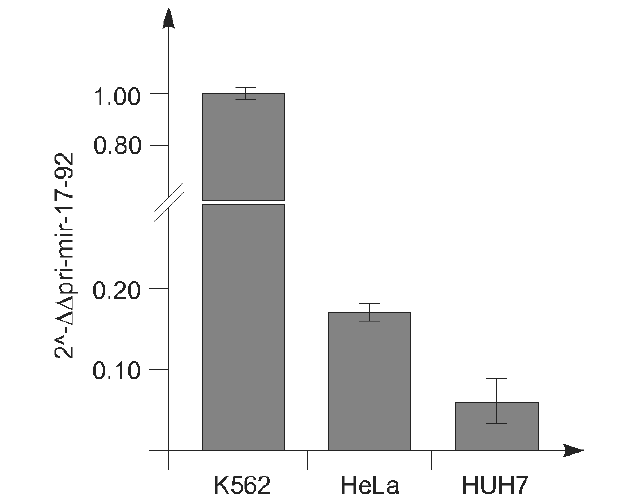
Figure S2. Quantitative RT-PCR of the pri-mir-17-92 transcription levels in the human cell lines K562, HeLa and HUH7 (hepato cellular carcinoma cells). 2^- ΔΔ pri-mir-17-92 values are normalized against 5S rRNA and obtained from at least 3 independent experiments (+/ − S.E.M.). The amount of pri-mir-17-92 transcript in K562 cells was set to